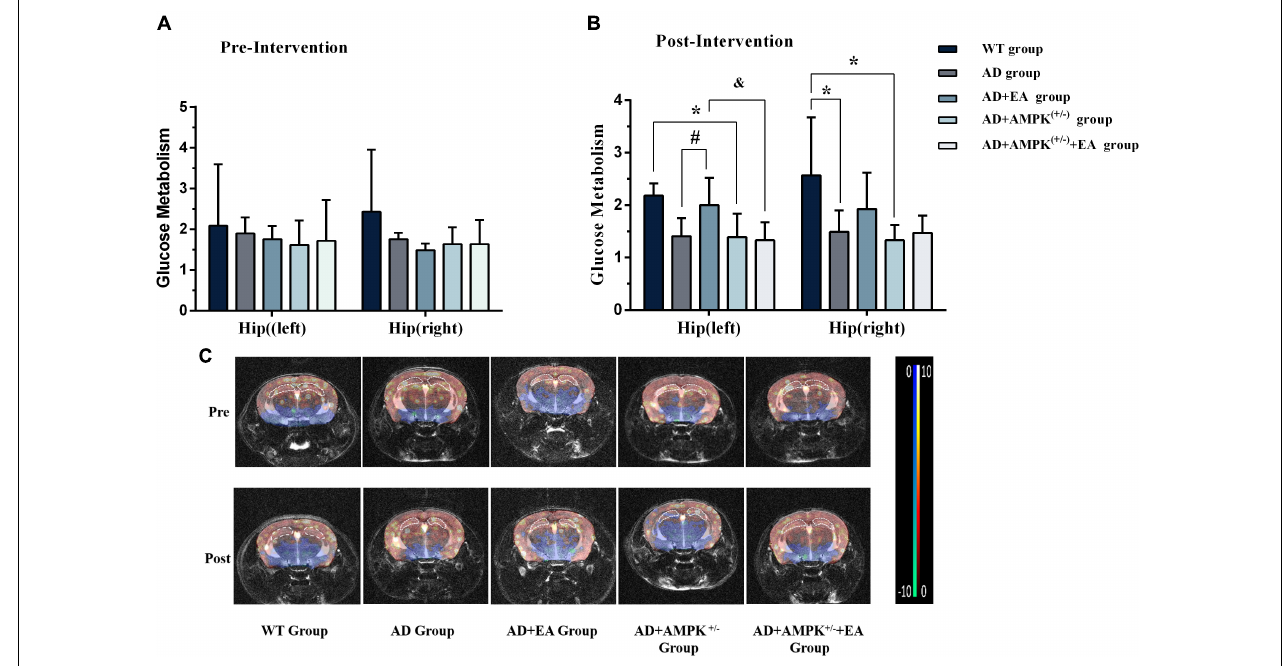
FIGURE 4 | Electroacupuncture intervention could increase glucose metabolism in the hippocampus of APP/PS1 mice. (A) The glucose metabolism in the hippocampus of five groups before EA intervention; (B) The glucose metabolism in the hippocampus of five groups after EA intervention; (C) The typical image of glucose metabolism in the hippocampus. * P < 0.05 vs. the WT group; # P < 0.05 vs. the AD group; & P < 0.05 vs. the AD + EA group.